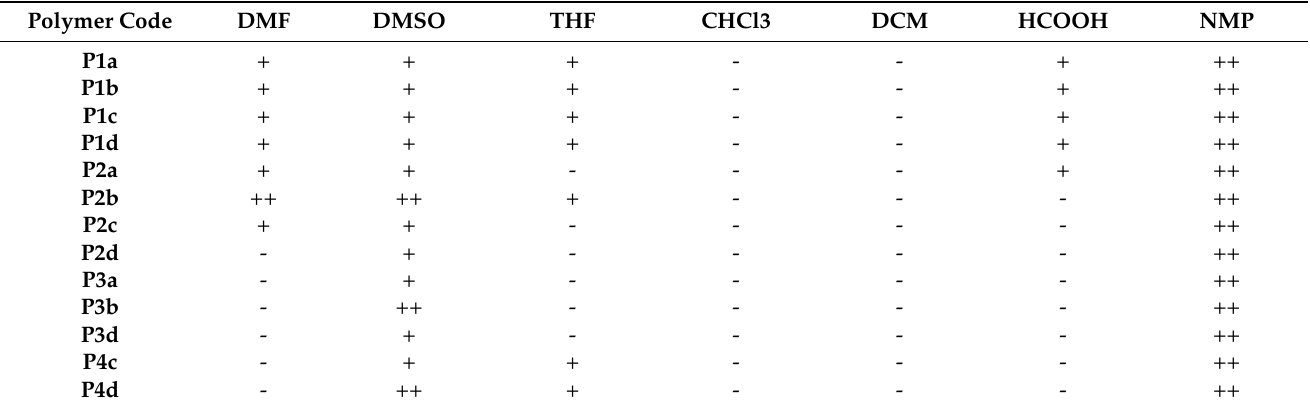
Table 1. Solubility characteristics of the polyamides P1a–d, P2a–d, P3a,b,d, and P4c,d. Polymer